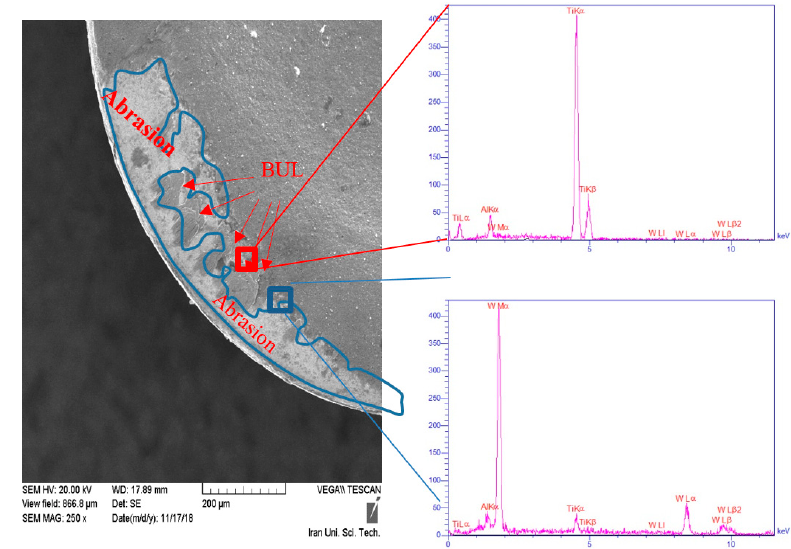
Figure 4. SEM and EDX images for insert 1 (TS2500) after 0.5 s of cutting. Table 3. The elemental compositions (wt.%) on the worn areas presented in both inserts in Figures 4 and 5. Insert TS2000 Insert TS2500 Elements / Insert Abrasion